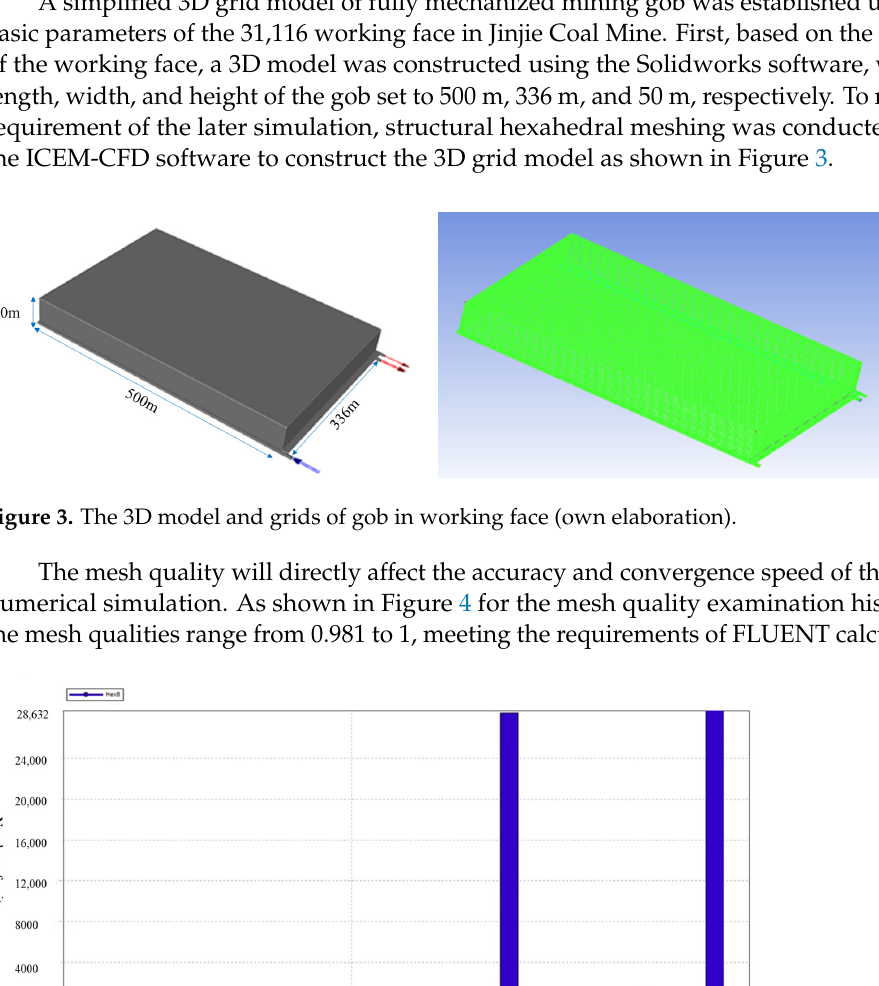
3. Results 3.1. Field Measurement Results of Gas Distribution After the gas monitoring pipelines were installed in the gob, a gas sample was col ‐ lected at each measuring point every day at the same time during the normal working face caving and analyzed by gas chromatograph for oxygen concentration. The definition of an oxidation zone is generally based on three parameters, air leakage speed, temperature rise rate, and oxygen concentration in the gob. The first two are mostly used in theoretical calculations and are significantly affected by caving conditions. In par ‐ ticular, it is difficult to obtain the actual temperature rise rate and air leakage speed of a gob. Therefore, in this study, an area with the oxygen concentration in the range of 8–18% is defined as an oxidation zone. The measured oxygen concentrations on the intake airway side, the middle, and the return airway side of the gob were classified, compared, and ana ‐ lyzed. As can be seen from Figure 5, the oxygen concentration in the goaf generally presents a downward trend but there is a certain fluctuation phenomenon. This is mainly due to the complex law of air leakage along the gob ‐ side entry retaining. In addition, due to the different temperatures each day, the underground air pressure is different and the changes in natural wind pressure will also lead to the distribution of oxygen in the goaf. Figure 5a shows that, when the 1# measuring point advanced to 136.4 m, the oxygen con ‐ centration drops from 18.76% to 17.07% and the point evolves from heat dissipation zone to oxidation zone. When the 2# measuring point advanced to 158.1 m, the oxygen concen ‐ tration drops from 20% to 17.94% and it enters the oxidation zone from the heat dissipa ‐ tion zone. According to Figure 5b, because its position is close to the return airway, the 3# measuring point does not enter the oxidation zone from the heat dissipation zone until advancing to 210.2 m. At this point, the oxygen concentration drops from 18.62% to 17.72%. The oxygen concentration at 4# measuring point in the return airway also shows a decreasing trend as the working face advanced. It enters the oxidation zone as it ad ‐ vances to 160.1 m when the oxygen concentration drops from 19.29% to 17.85%. It can be explained that the oxidation of residual coal in the gob gradually consumes the oxygen, and the fresh air flow cannot effectively compensate for the consumed oxygen through the air leakage channel. In addition, the oxidation gradually reduces the amount of resid ‐ ual coal available for the reaction. Therefore, due to the limitation of field conditions, it is difficult to accurately define the range of gob spontaneous combustion “three zones” only